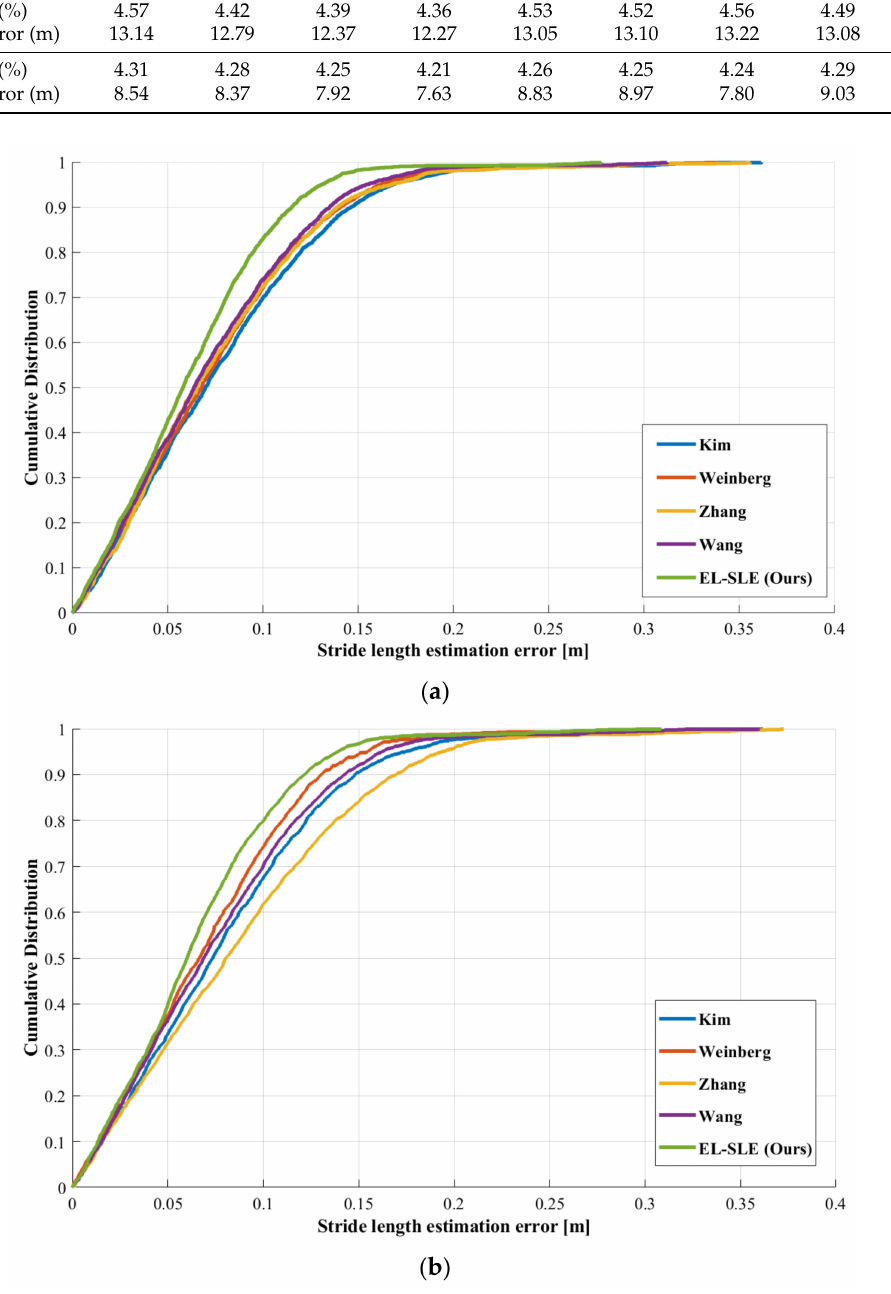
Figure 15. Cumulative distribution diagram of absolute errors of stride-length estimation with different SLE models on sequences #1 ( a ) and #21 ( b